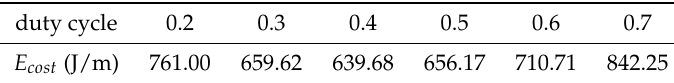
Figure 17. The energy consumptions with different duty cycles. Table 8. E cost with different duty